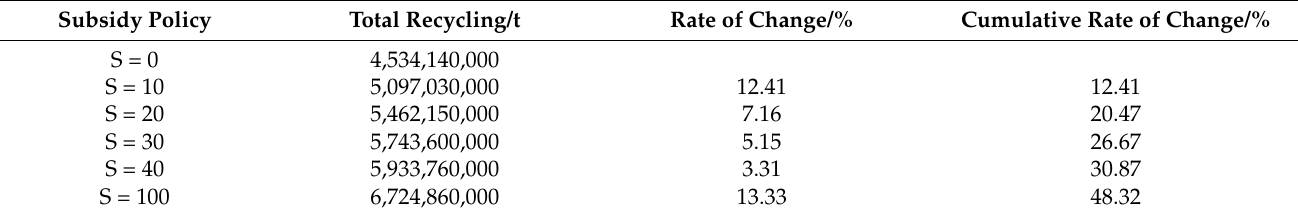
Table 3. Changes in total recovery corresponding to different subsidies.